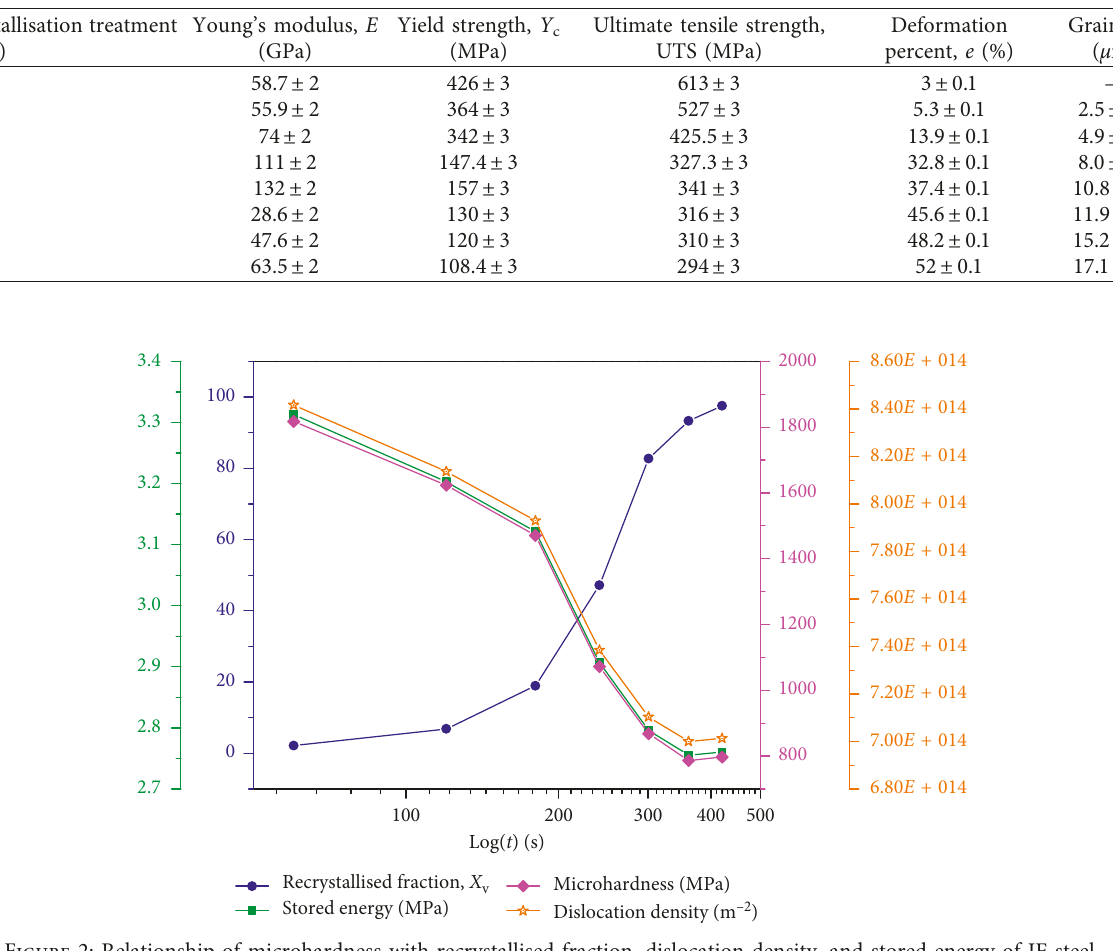
Figure 2: Relationship of microhardness with recrystallised fraction, dislocation density, and stored energy of IF